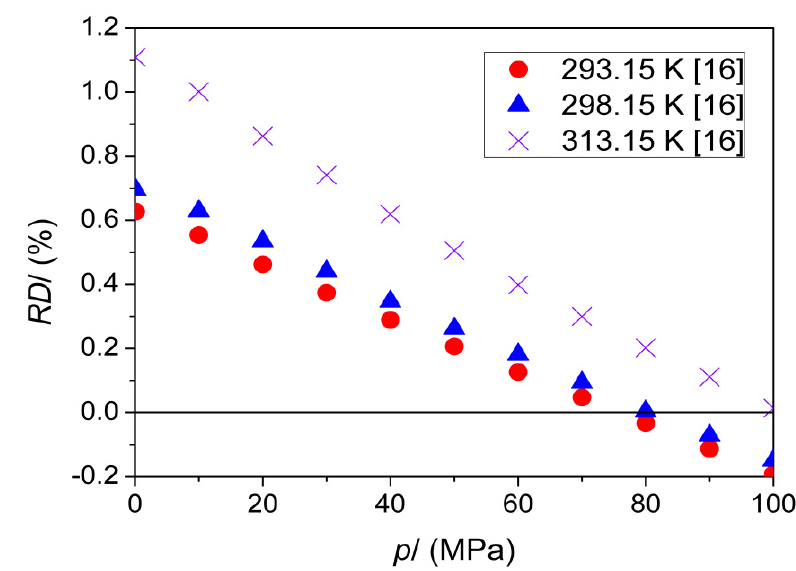
Figure 9. Comparison of the isochoric heat capacity of 1-butanol as a function of pressure obtained in this work ( C V , this work ) with the literature values ( C V , lit ) [16] presented as relative deviations RD s ( RD / % = 100 · ( C V , this work − C V , lit ) / C V , this work ).